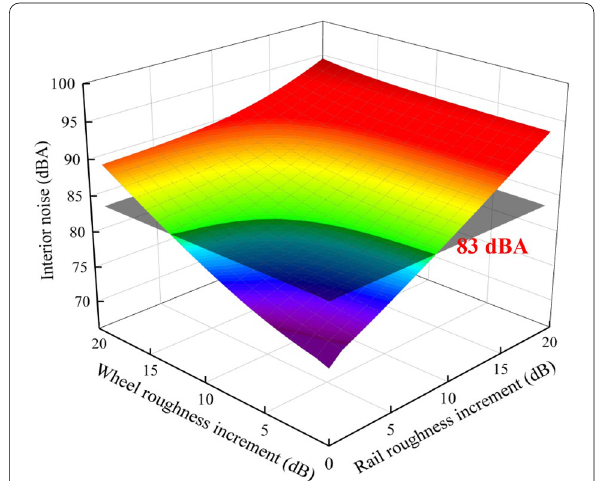
Figure 9 Relationship between wheel/rail roughness and interior noise